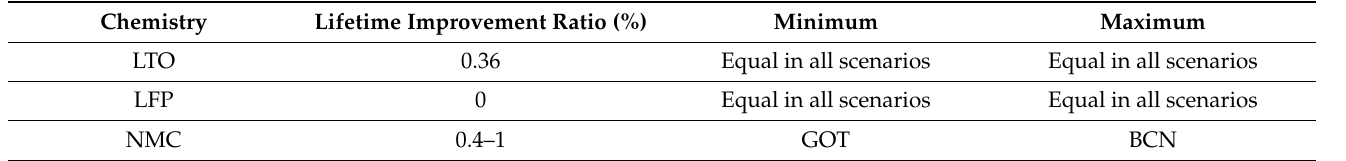
Table 10. Summary of results for the sensitivity to the charger